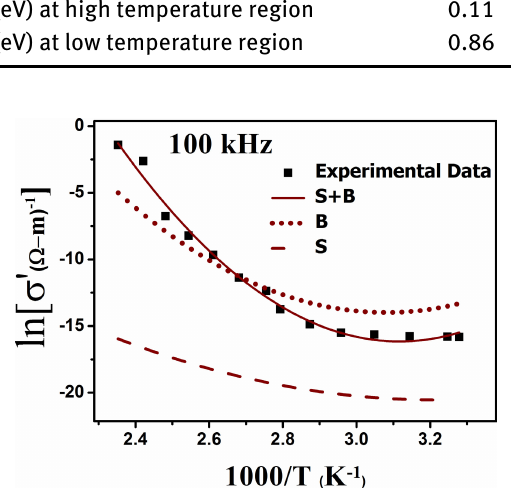
Table 1: Derived electrical parameter (activation energy) from Arrhenius plot. Derived electrical parameter